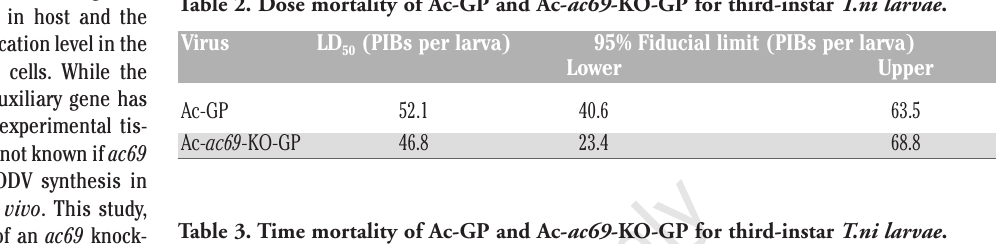
Table 3. Time mortality of Ac-GP and Ac- ac69 -KO-GP for third-instar T.ni larvae .